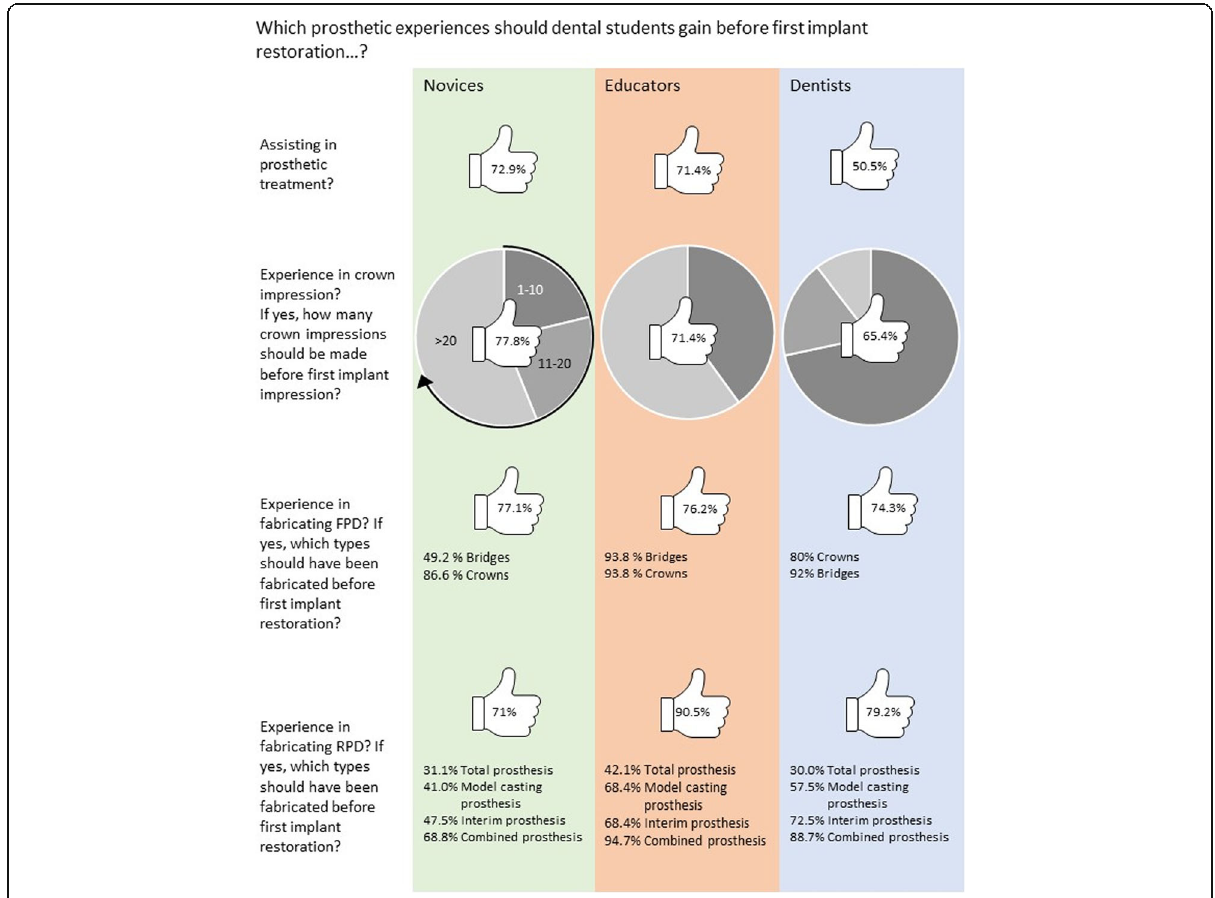
Fig. 5 Answers to questions about prosthetic prerequisite experiences before performing the first implant restoration. The percentages within the thumbs indicate acceptance (thumb up) or rejection (thumb down) within the three groups (i.e., novices, educators, and dentists). FPD, fixed partial denture; RPD, removable partial